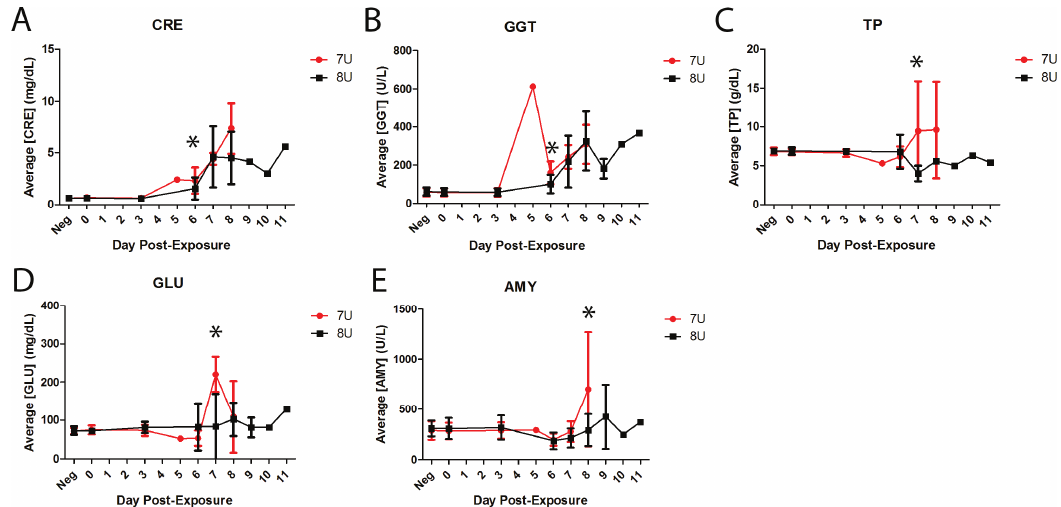
Figure 4. Average serum chemistry in naïve challenge groups. All error bars represent standard deviation. Asterisks indicate statistically significant differences between the two groups (7U, n = 14, red ; 8U, n = 14, black ). ( A ) Average concentration of creatinine in serum for naïve NHPs shown in mg/dL; ( B ) Average concentration of gamma-glutamyl transpeptidase for naïve NHPs in serum shown in U/L; ( C ) Average concentration of total protein in serum for naïve NHPs shown in g/dL; ( D ) Average concentration of glucose in serum for naïve NHPs shown in mg/dL; ( E ) Average concentration of amylase in serum for naïve NHPs shown in U/L.